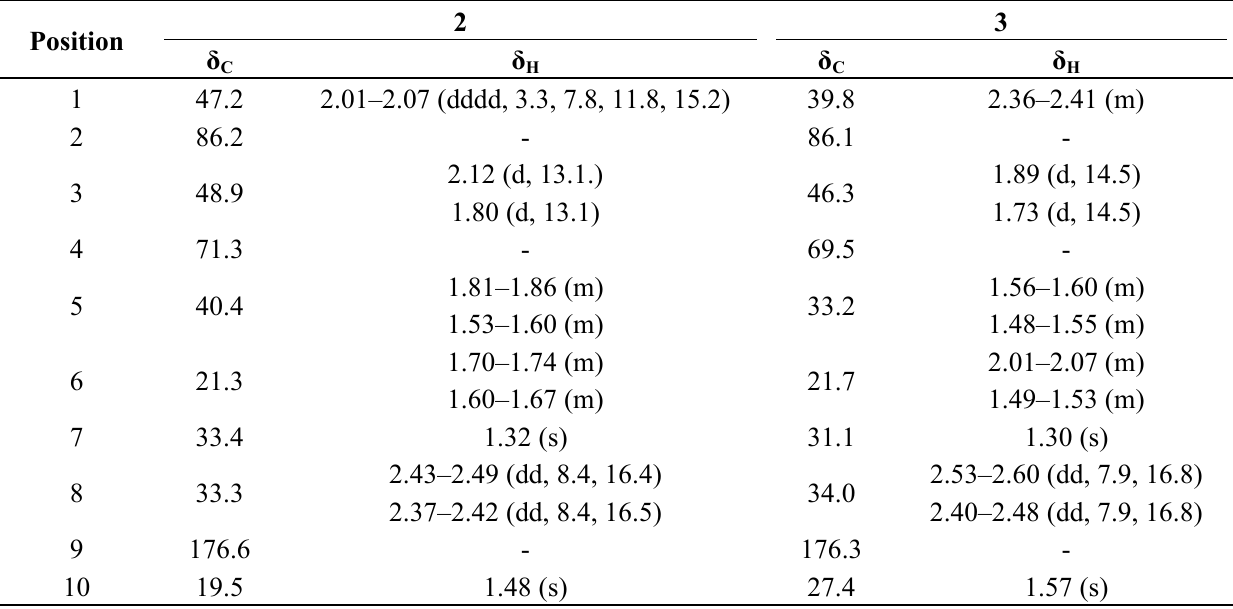
Table 2. 1 H- (400 MHz) and 13 C-NMR (100 MHz) data (CDCl Chemical shifts δ in ppm relative to TMS, J in